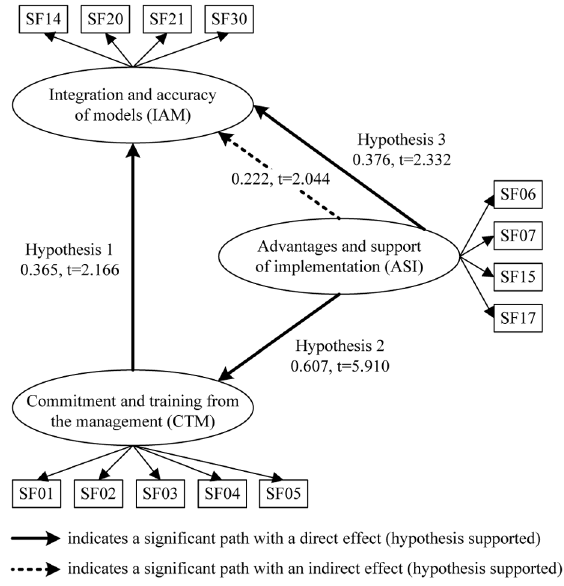
Fig. 2. Conceptual framework for enhancing BIM